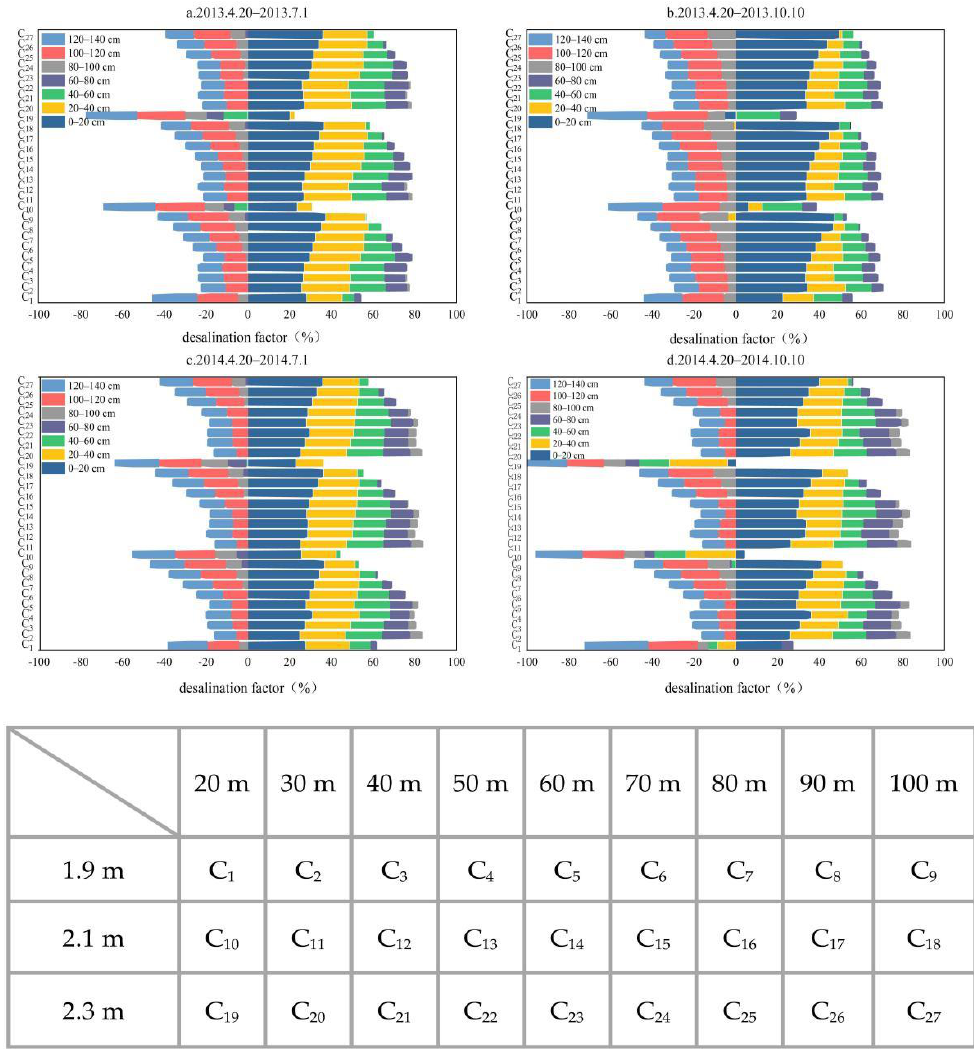
Figure 5. Distribution of the desalination rate at different periods in the 27 pipe Figure 5 . Distribution of the desalination rate at different periods in the 27 pipe layouts.